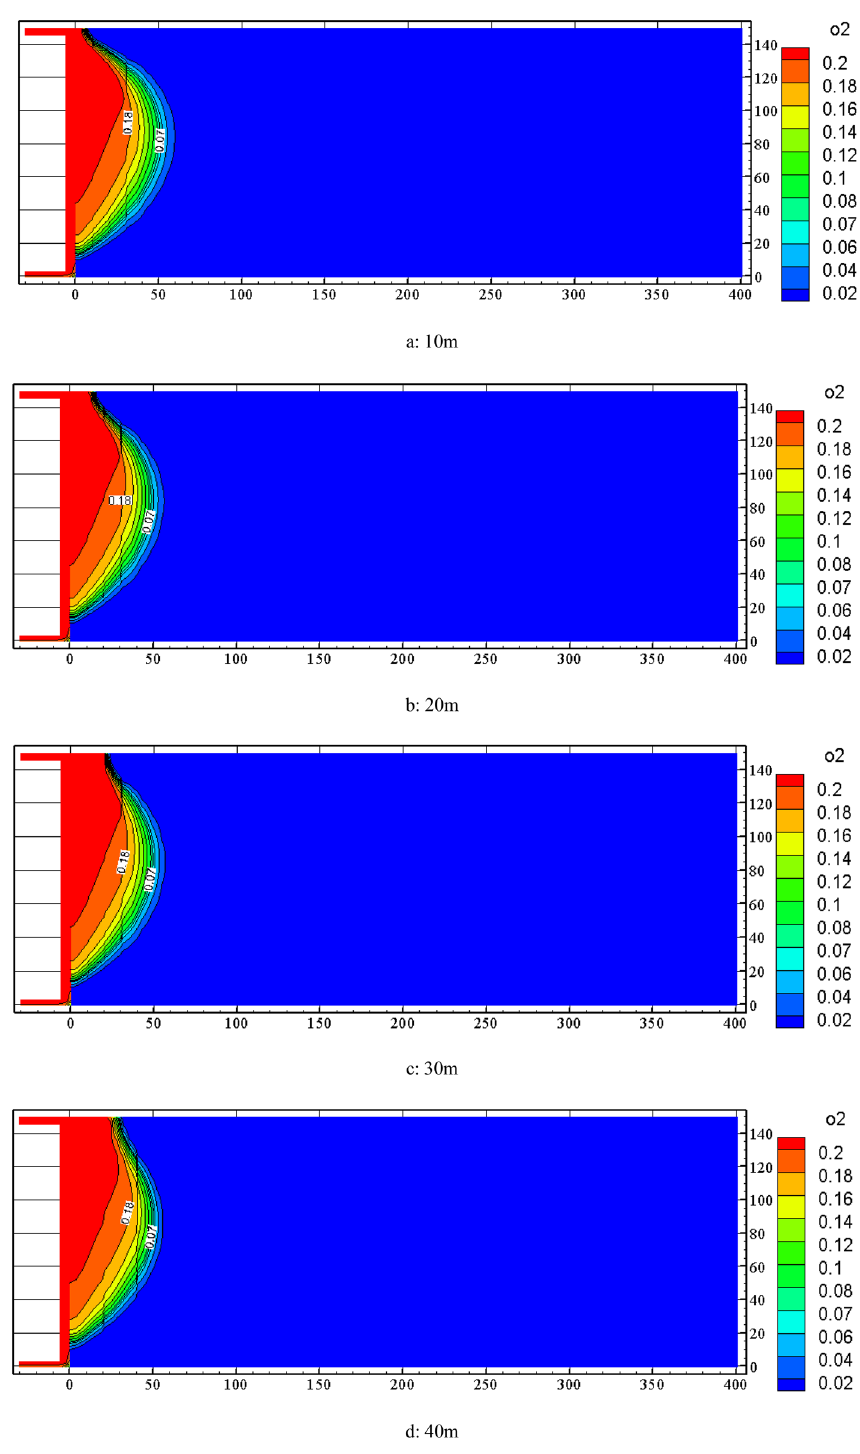
Figure 5. Distribution of oxygen concentration in goaf under different injection nitrogen